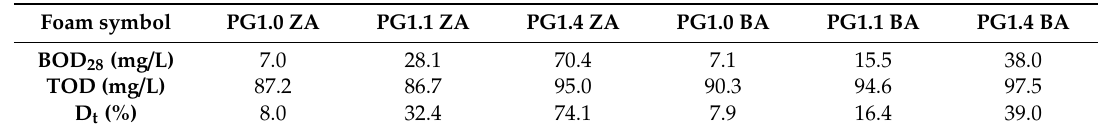
Table 7. Results of biodegradability RPU/PIR foams.